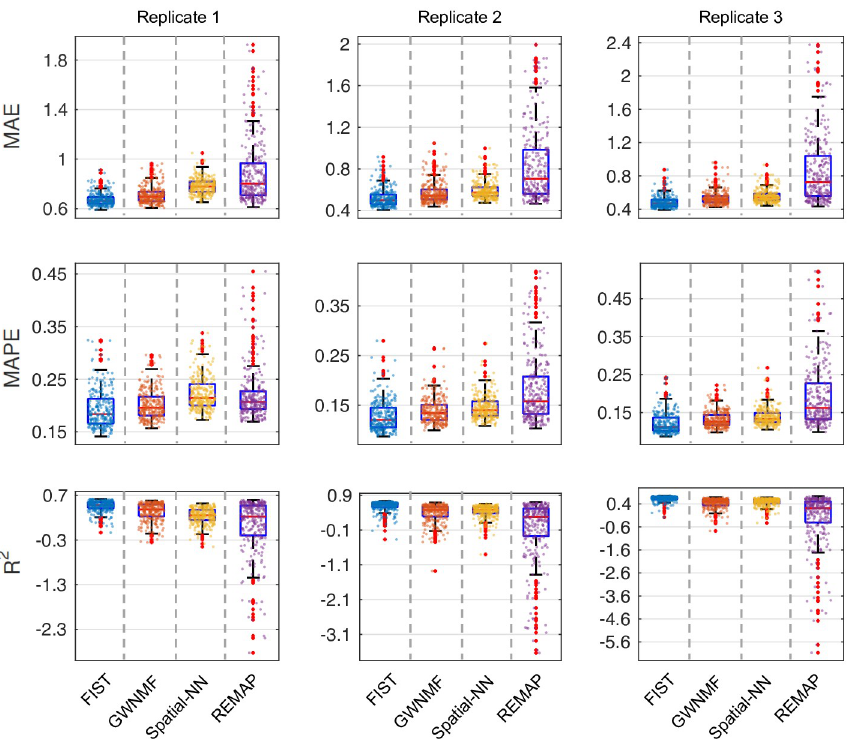
Fig 8. Spot-wise imputation performance on mouse tissue replicates. The performances of the four compared methods on the 3 replicates are measured by 5-fold cross-validation. The performance on each spatial spot is denoted by one dot in the box plots. The performances of different methods are shown in different